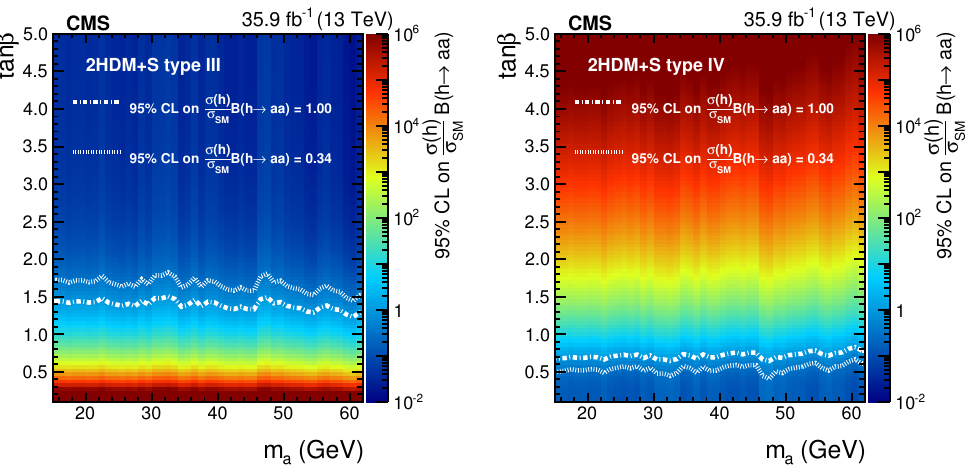
Figure 5 . Observed limits on ( (cid:27) h =(cid:27) SM ) B (h ! aa) in 2HDM+S type III (left) and type IV (right). The contour lines shown for B (h ! aa) = 1 : 0 and 0.34 correspond to the colour scale indicated on the right vertical scale. The number 0.34 corresponds to the limit on the branching fraction of the Higgs boson to beyond-the-SM particles at 95% CL obtained with data collected at center-of-mass energies of 7 and 8 TeV by the CMS and ATLAS experiments